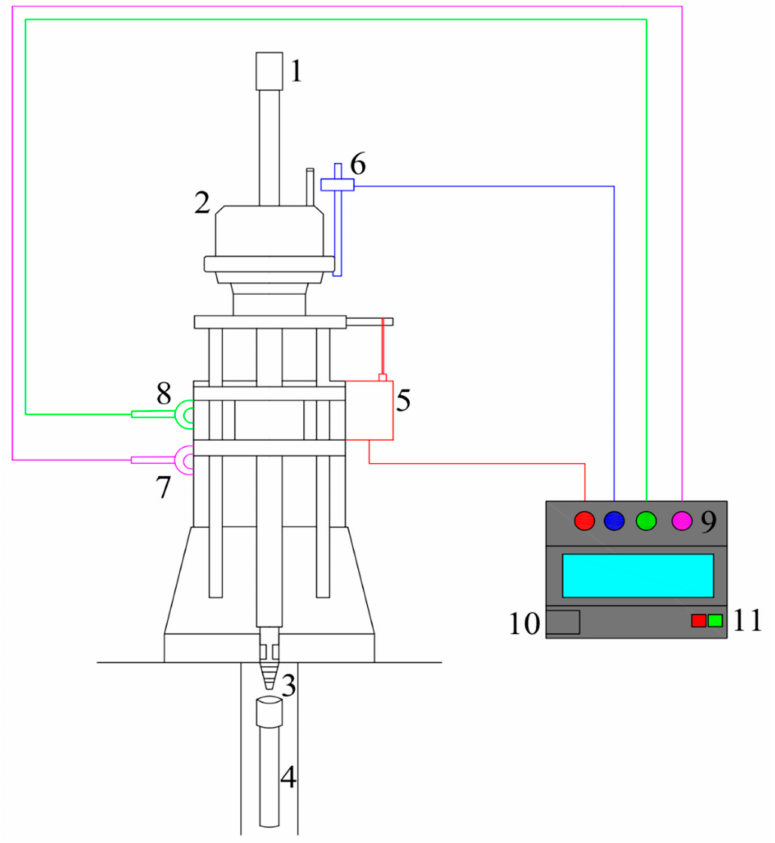
Figure 1. Schematic diagram of the DPM system installed on a drilling rig. 1–4 are some parts of the drilling rig (1: Drill rod; 2: Drill chuck; 3: Drill bit; 4: Coring Rod) and 5–11 are various parts of the DPM system (5: Displacement Sensor; 6: Rotation Sensor; 7: Oil Pressure Sensor for Oil Inlet Pipe; 8: Oil Pressure Sensor for Oil Outlet Pipe; 9: Data module; 10: Indicator; 11: Wireless transmission